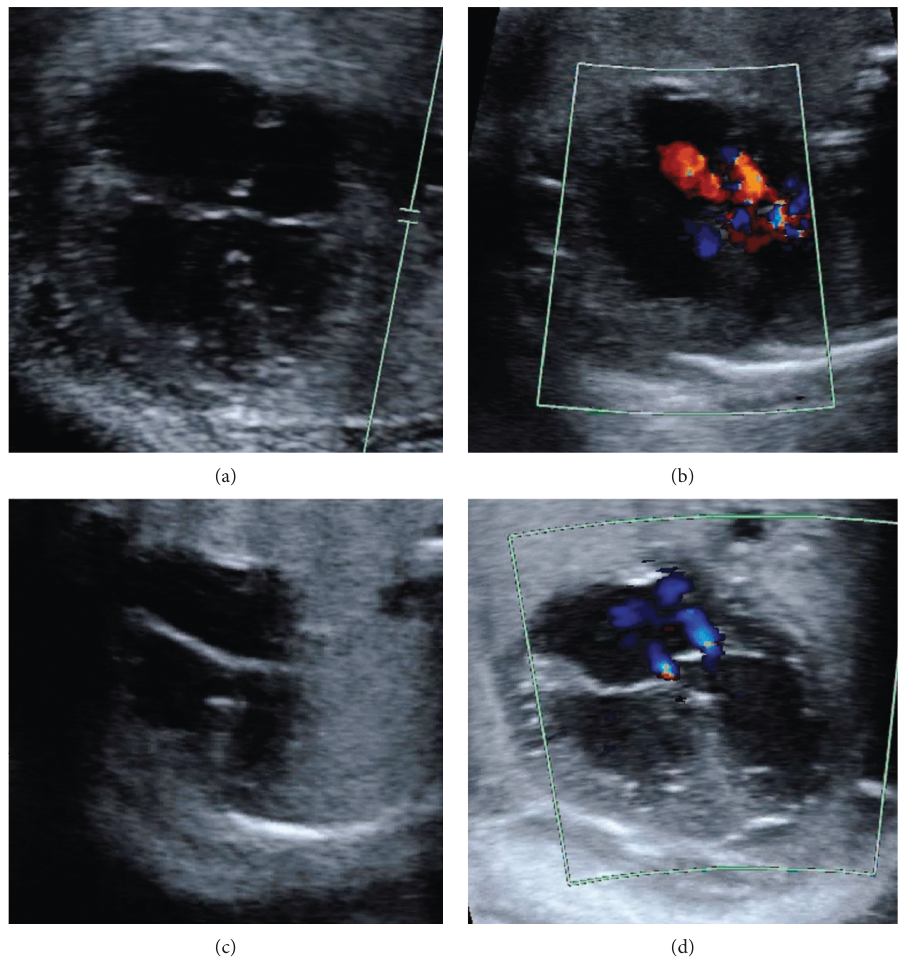
Figure 2: Fetal four-chamber cardiac images. (a) Twin A 2D imaging showing a ventricular septal defect, primum atrial septal defect, and secundum atrial septal defect. (b) Twin A color Doppler showing left and central atrioventricular valve regurgitation (red flashes moving toward the transducer). (c) Twin B 2D imaging showing a ventricular septal defect, primum atrial septal defect, and secundum atrial septal defect (drop out artifact between these defects gives the incorrect appearance of a large single defect). (d) Twin B color Doppler showing left and central atrioventricular valve regurgitation (blue flashes moving away from the